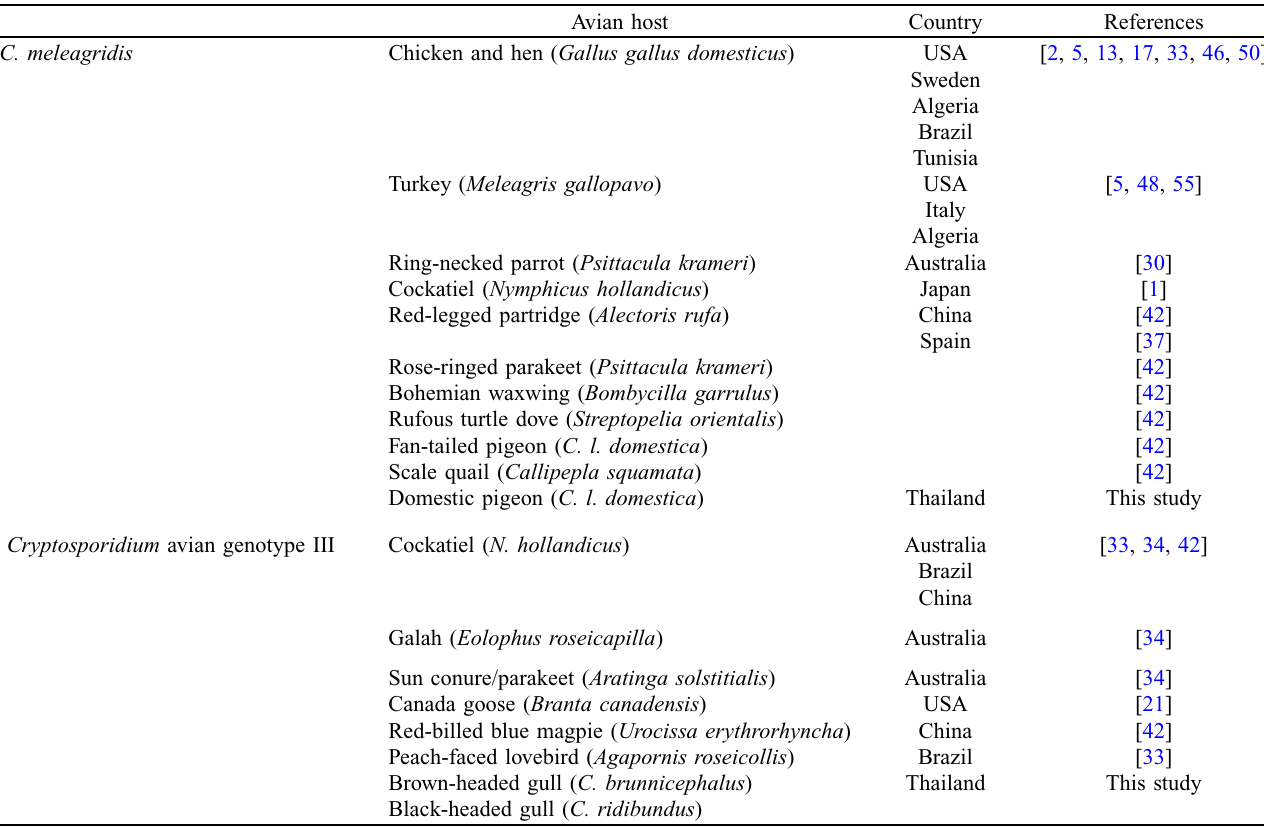
Table 2. Avian host and country of identification of C. meleagridis and Cryptosporidium avian genotype III, from published records.